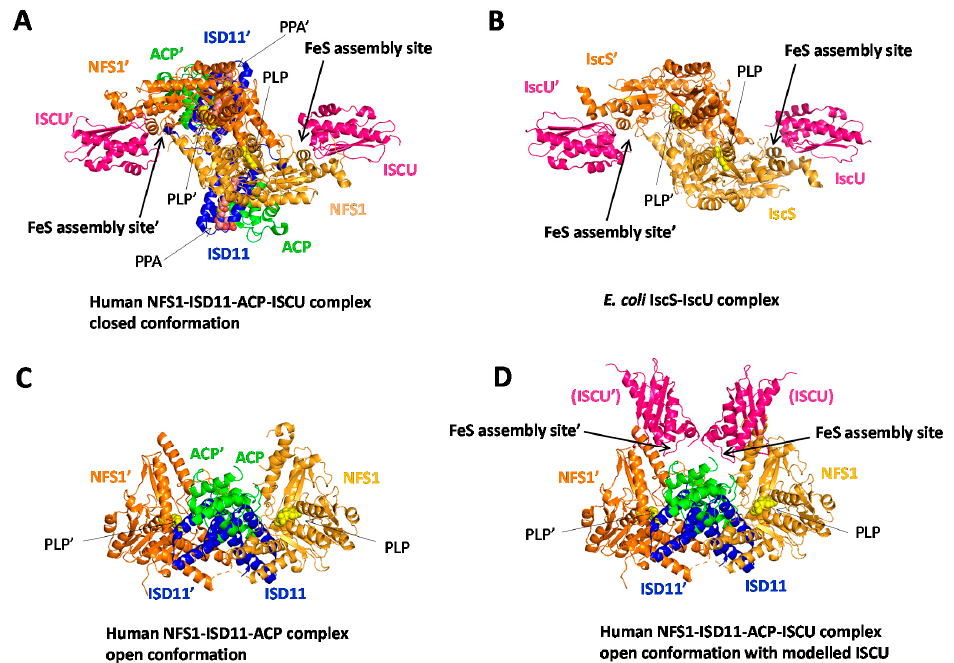
Figure 3. Structures of the human NFS1–ISD11–ACP–ISCU and E. coli IscS–IscU complexes. X-ray structures of ( A ) human NFS1–ISD11–ACP–ISCU complex in the closed conformation (PDB code 5WLW) [67], ( B ) E. coli IscS–IscU complex (PDB code 3LVL) [150], ( C ) human NFS1–ISD11–ACP complex in the open conformation (PDB code 5USR) [151] and ( D ) human NFS1–ISD11–ACP complex in the open conformation (PDB code 5USR) with the human ISCU proteins modeled according to the structure of the NFS1–ISD11–ACP–ISCU complex (PDB code 5WLW). The labels for the ACP protein have been omitted for clarity in D. IscS / NFS1 are colored in orange, IscU / ISCU in pink, ISD11 in blue and ACP in green. The pyridoxal phosphate (PLP)-binding sites, the phosphopantetheine with its fatty acyl chain (PPA) and the Fe–S cluster assembly sites of IscU / ISCU are indicated by